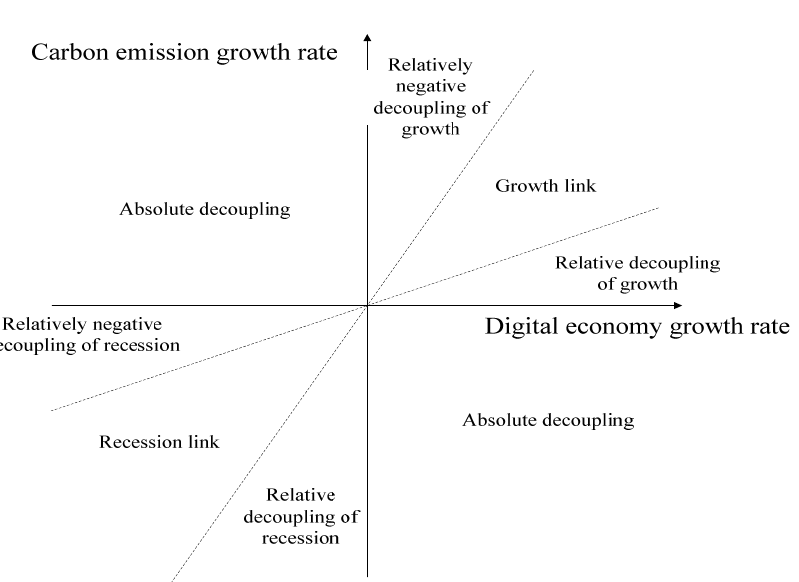
Figure 1. Classification diagram of decoupling